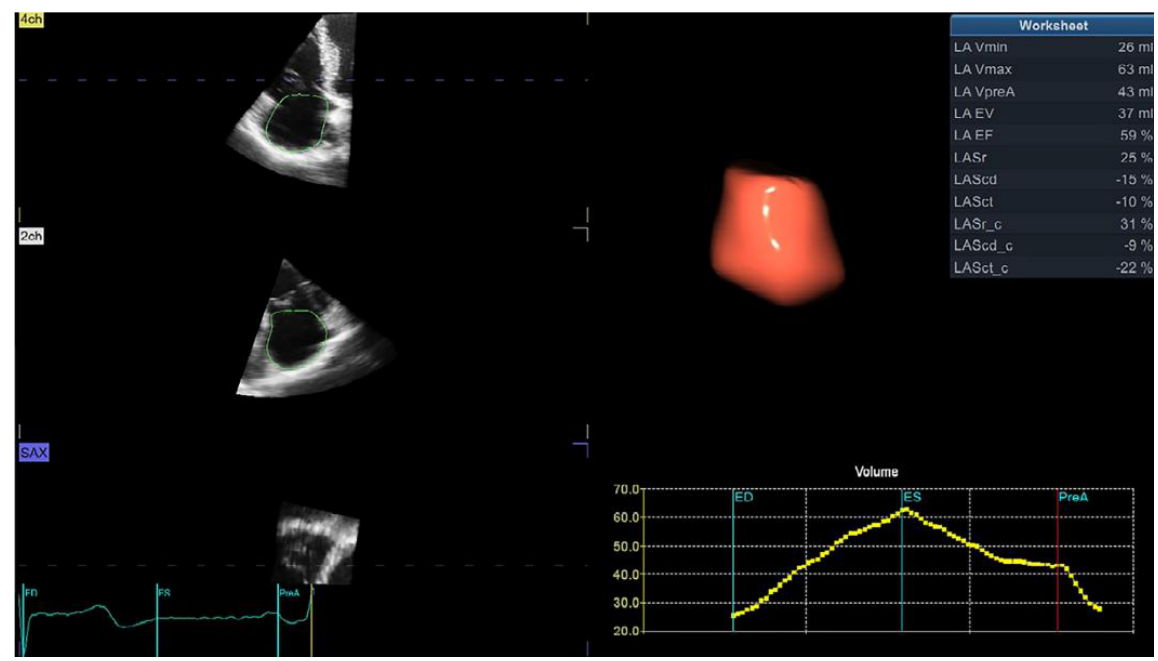
Figure 2. Three-dimensional echocardiographic volume- and strain-derived right atrial phasic analysis (software is dedicated for left atrial analysis and, therefore, all acronyms are devoted to the left atrium (LA) and should be replaced with the right atrium (RA) as the same software is used off-label for the RA). ED—end-diastole, ES—end-systole, LA EV—left atrial emptying volume, LA EF—left atrial emptying fraction, LASr—left atrial longitudinal strain during reservoir phase, LAScd— left atrial longitudinal strain during conduit phase, LASct—left atrial longitudinal strain during contraction phase, LASr_c—left atrial circumferential strain during reservoir phase, LAScd_c—left atrial circumferential strain during conduit phase, LASc_ct—left atrial circumferential strain during contraction phase, LA Vmax—maximum left atrial volume, LA Vmin—minimum left atrial volume, LA VpreA—left atrial volume before atrial contraction, pre-A—before atrial contraction.